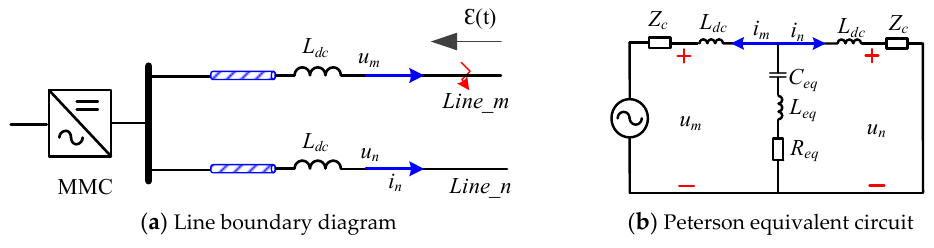
Figure 4. Boundary of the HVDC grid line. According to the equivalent circuit shown in Figure 4, the initial ‐ fault ‐ voltage trav ‐ eling wave and current traveling wave corresponding to measurement points m and n are calculated in the S domain, and their expressions are as follows [17].